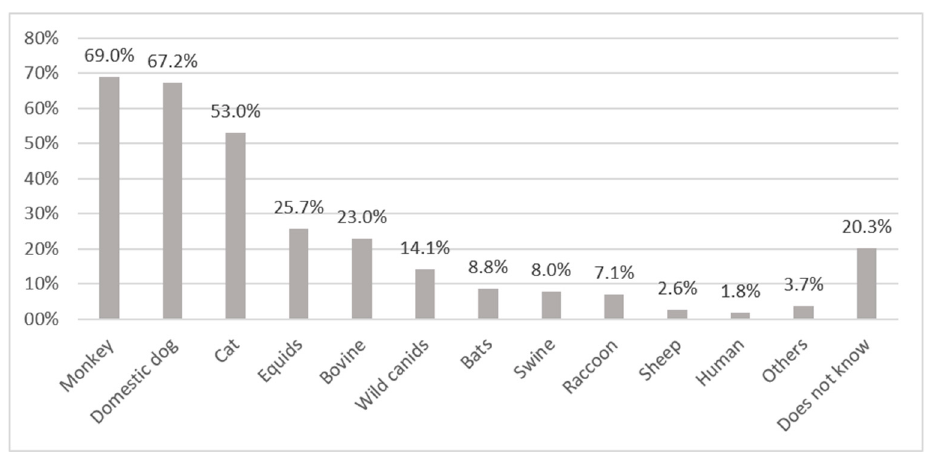
of transmission at all. About 52% mentioned correctly animal bites and 6% scratches, but 12% believed that mosquitoes would transmit rabies. Other incorrect modes of transmis- Figure 2. Animals or categories of animals reported by respondents to be rabies virus transmitting Figure 2. Animals or categories of animals reported by respondents to be rabies virus transmitting animals. Others: snake (0.9%), parrot (0.9%), jaguar (0.9%), goat (0.9%), opossum (0.1%). animals. Others: snake (0.9%), parrot (0.9%), jaguar (0.9%), goat (0.9%), opossum (0.1%). sion cited by respondents included transmission by urine and feces (Figure 3).